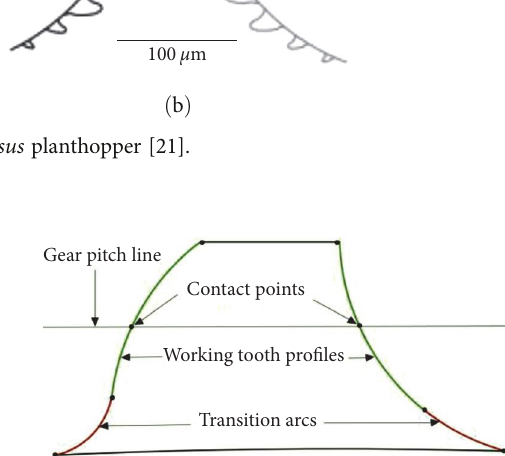
F IGURE 2: Tooth pro fi le of the asymmetric logarithmic spiral